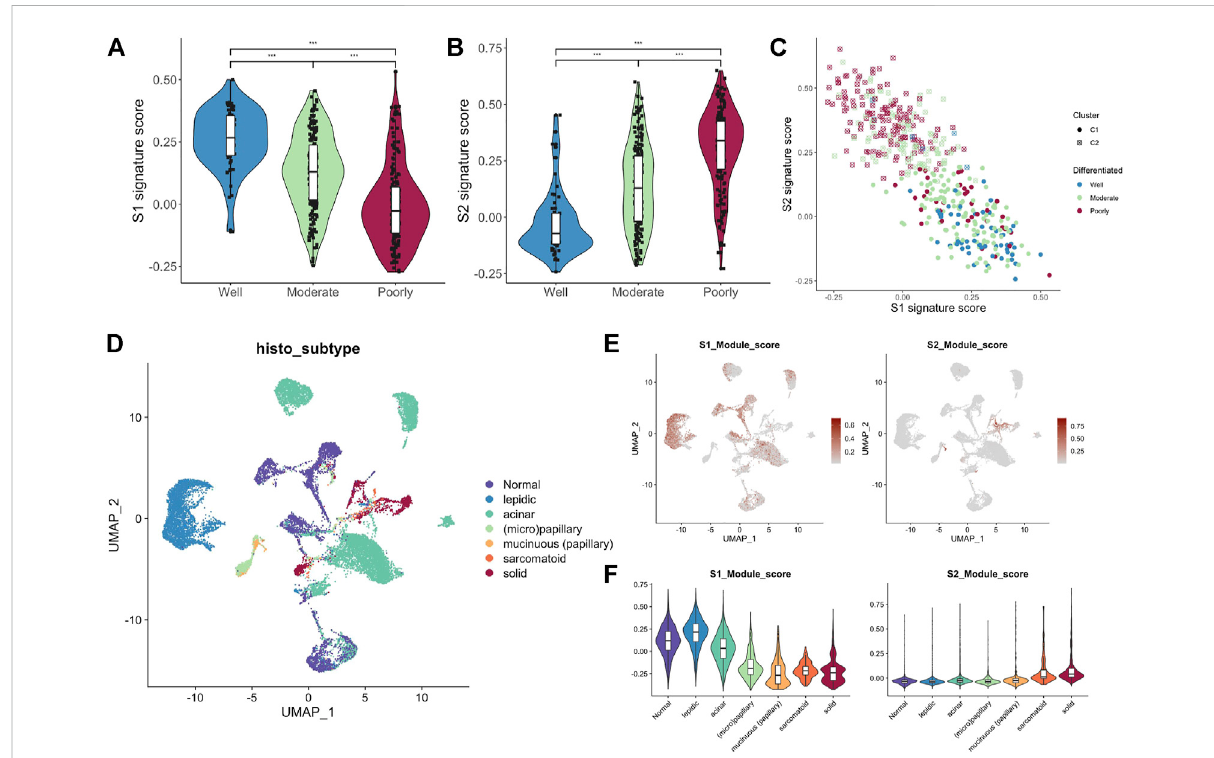
FIGURE 7 MYC-signalingishighlycorrelatedwithcelldifferentiation. (A) TherelationbetweentheS1signaturescoreandcelldifferentiationinGSE68465. (B) The relation between the S2 signature score and cell differentiation in GSE68465. (C) The connection between S1 signature score, S2 signature score,MYCsignaling,andcelldifferentiationinGSE68465. (D) UMAP analysis identi fi escellpopulationsofdifferenttissuesubtypes (E,F) Theaverage expression level of S1/S2 signature genes in each single cell was calculated by the AddMouduleScore